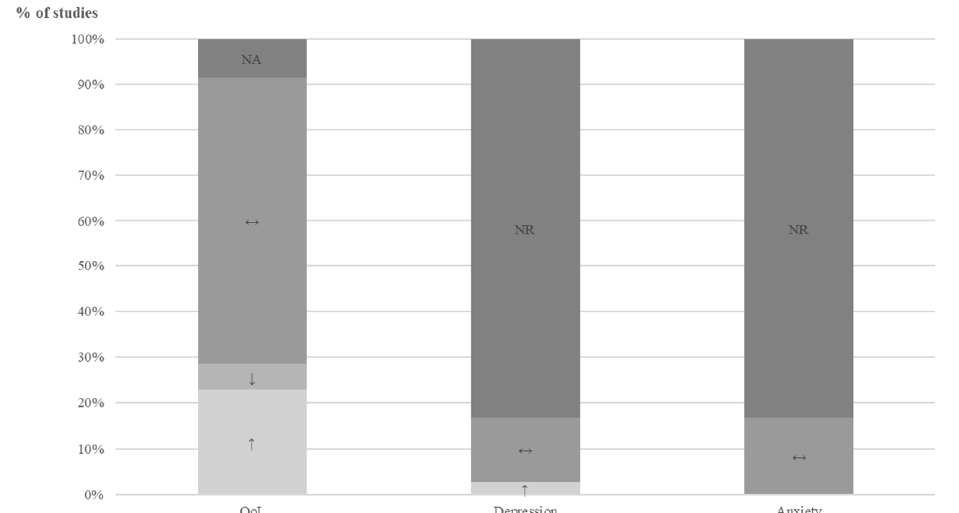
probiotic versus placebo intervention across studies. NR: not reported; NA: not applicable; QoL: quality of life; ↔ : no significant differences between groups; ↑ : improvement; ↓ : deterioration .